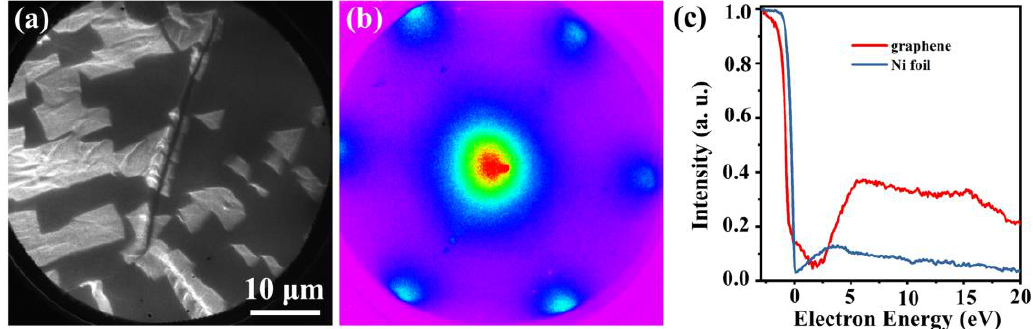
Figure 1. ( a ) LEEM image of graphene domains formed on the bared Ni surface at 650°C. ( b ) μ-LEED pattern (50 eV) acquired from the forming graphene domains. ( c ) LEER spectra acquired from graphene domains and the bared Ni surface, respectively.